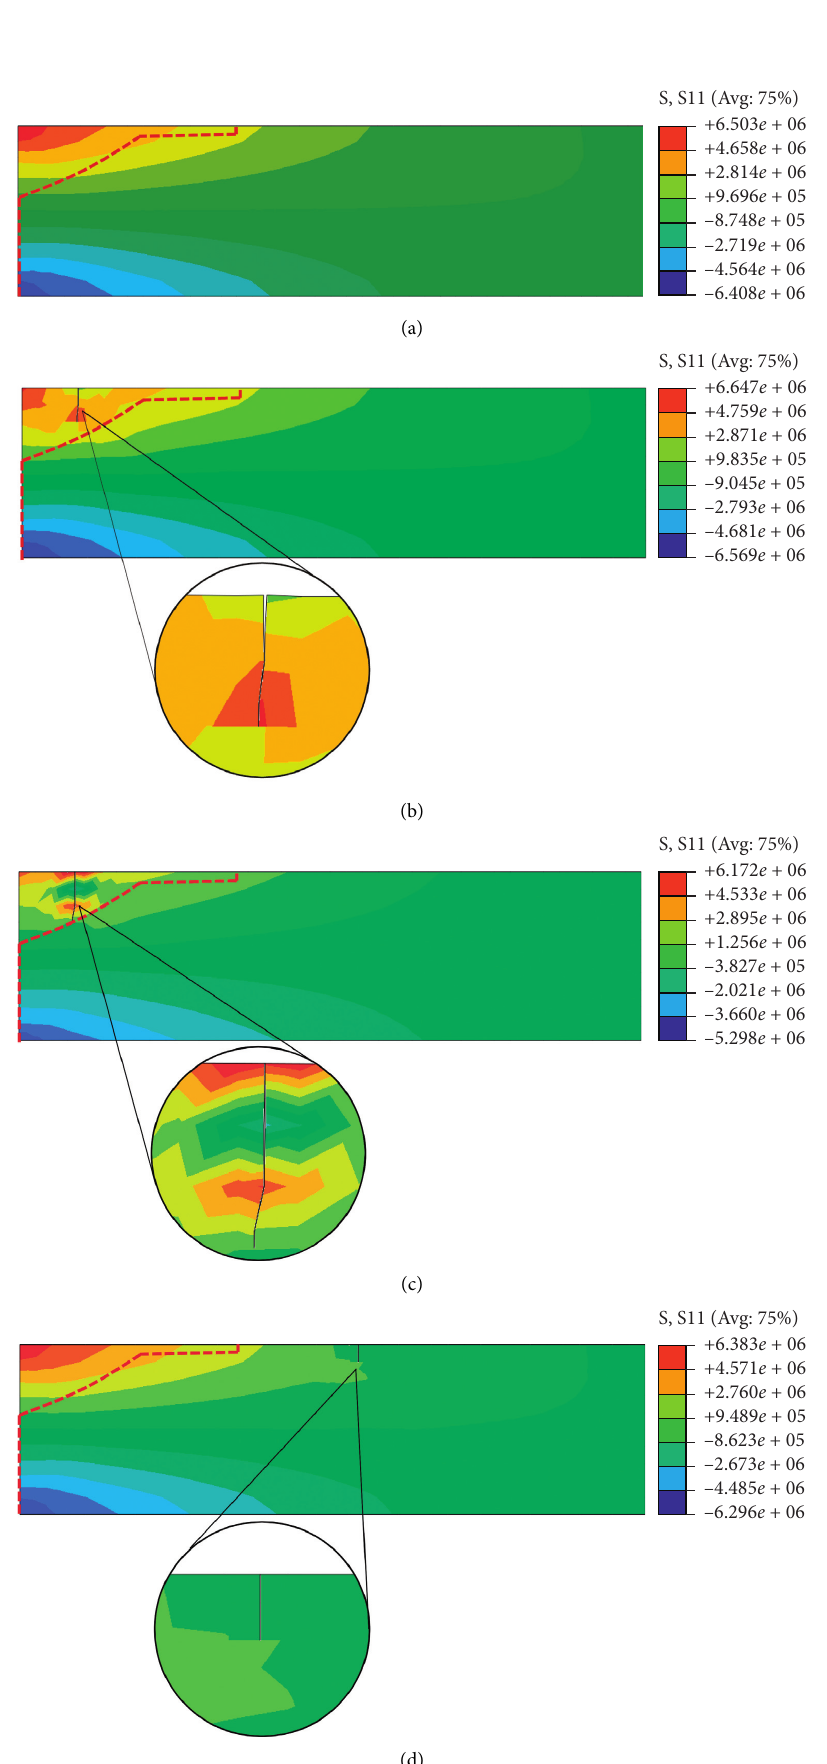
Figure 14: Normal stress of roof under different crack positions. (a) Crack-free. (b) At the edge of crack-affected area. (c) In the interior of crack-affected area. (d) In the crack-unaffected